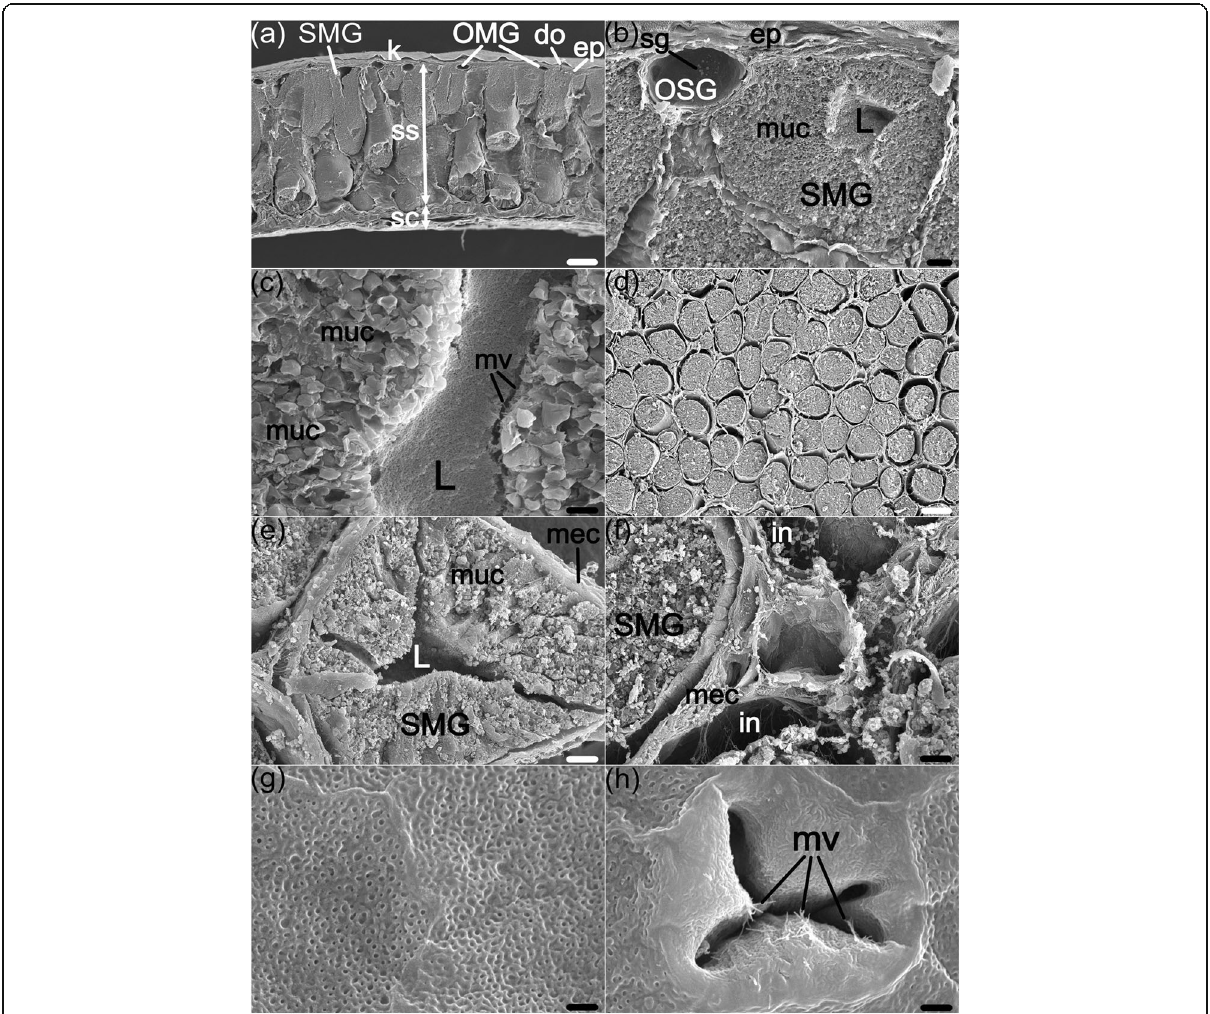
Fig. 3 Scanning electron micrographs of the postaxillary glands in male N. pleuraden . a Transverse section of the postaxillary gland. b Higher magnification image of specific regions in ( a ), showing an OSG and a SMG. c Mucocytes surround an obvious lumen in SMGs. d Longitudinal section of the postaxillary gland. e Longitudinal section of a SMG, its lumen is surrounded by numerous mucocytes and the mucocytes are all encircled by the myoepithelial sheath. f A complex, irregular connective structure locates at the interstice between myoepithelial sheaths. g Normal texture of the skin surface of the postaxillary gland. h A close-up of the glandular outlet, note the intraductal microvilli. ep, epidermis; do, duct opening; SMG, specialized mucous gland; OMG, ordinary mucous gland; OSG, ordinary serous gland; sg, secretory granule; ss, stratum spongiosum ; sc, stratum compactum ; muc, mucocyte; mec, myoepithelial cell; L, lumen; mv, microvilli; in, interstice. Bars = 500 μ m ( a , d ), 50 μ m ( b , e , f ), 10 μ m ( c ) and 5 μ m ( g , h